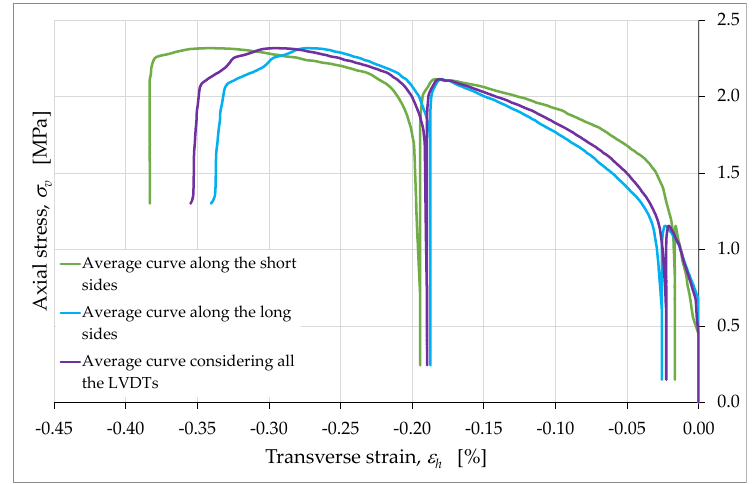
Figure 18. Average curves of axial stress with respect to transverse strain, obtained from the relative displacements over the short and the long side faces.